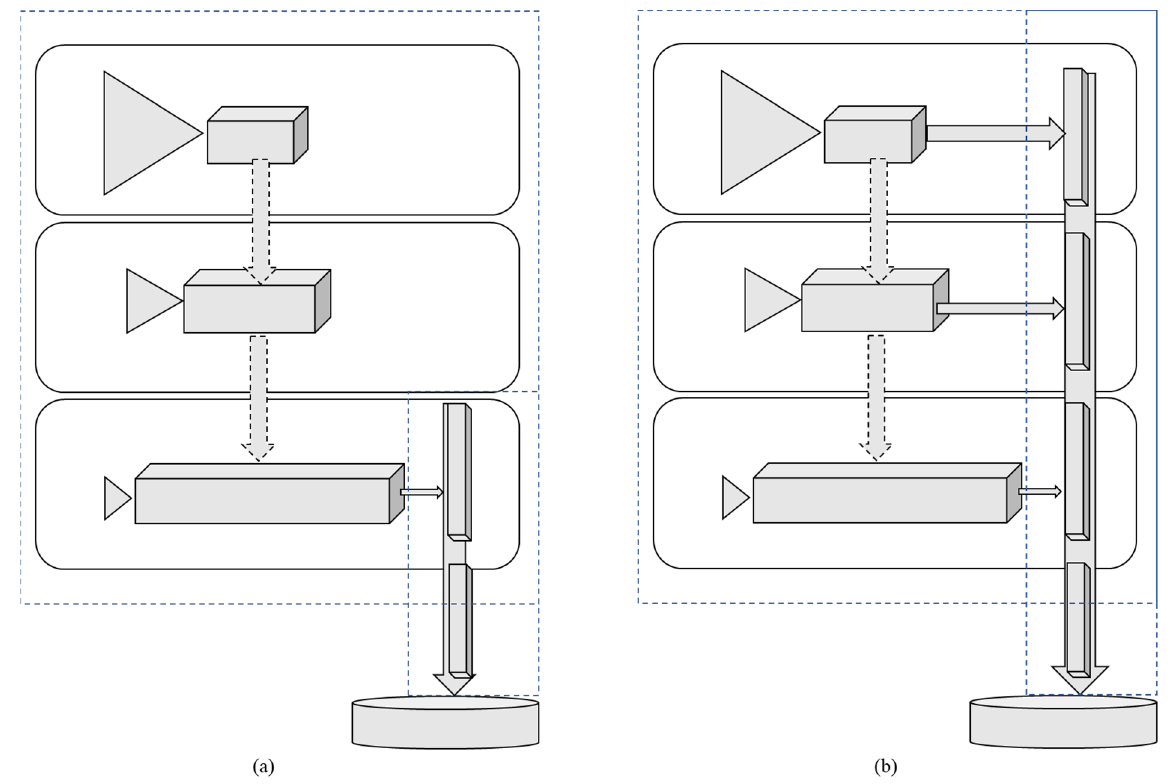
Figure 2. A conceptualisation of the “switch” in connectivity in a catchment. ( a ) presents a (dis)connected catchment and ( b ) presents a connected catchment. Refer to Figure 1 for a description of the key.